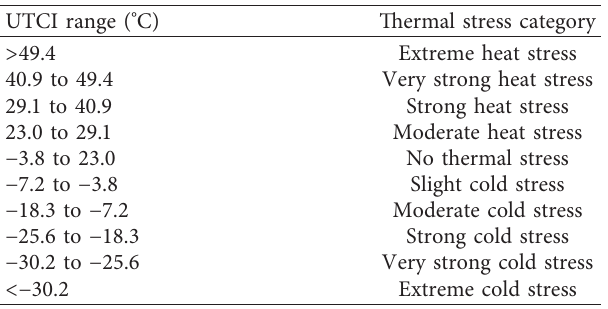
Table 5: Thermal classification of UTCI equivalent temperatures for Harbin [50].